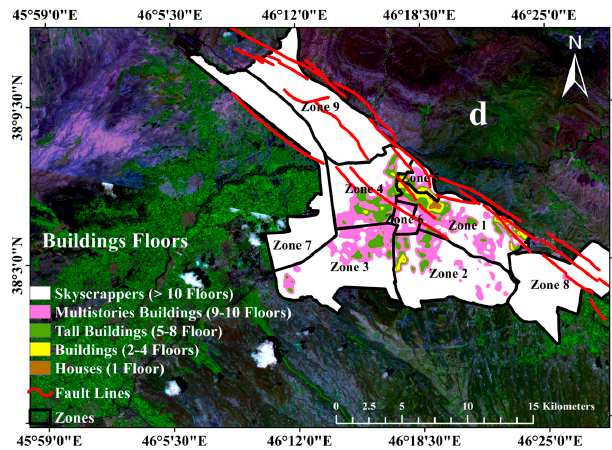
Figure 4. Distribution of ( a ) buildings materials ( b ) size of buildings density ( c ) quality of buildings and ( d ) buildings floor in Tabriz city.